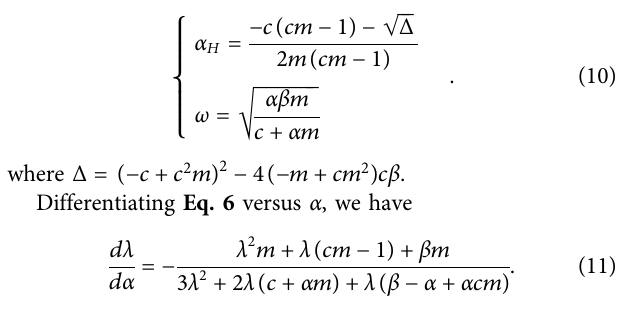
Figure 3 . Coexisting symmetric periodic-1, periodic-2, and periodic-4 attractors are found in Figures 3A – C ; coexisting chaotic attractors are observed in Figure 3D . Figures 3E,F do not show coexisting attractors, but different chaotic attractor and periodic circle are found. However, it shows only two coexisting symmetric attractors. Meanwhile, it shows that there are third regions in the basin